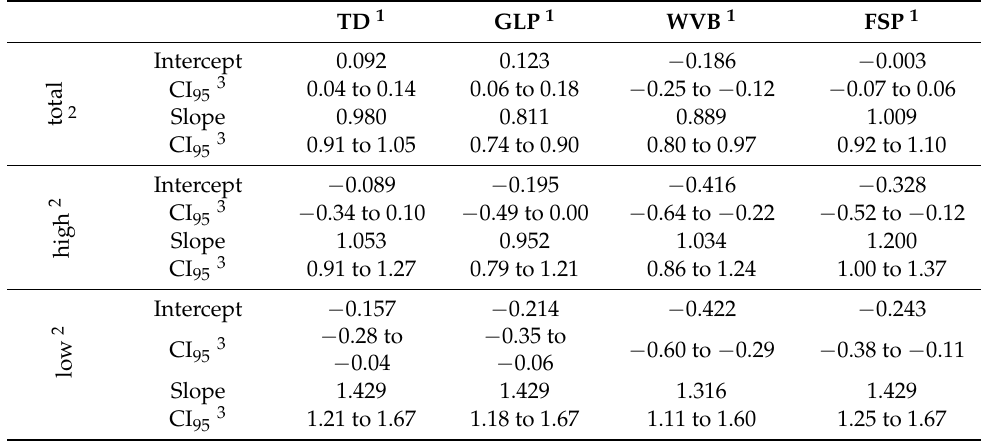
Table 4. Passing–Bablok regression coefficients calculated for the classes total, high and low for BHBA concentrations measured in whole blood with 4 handheld devices in comparison with the BHBA concentration in blood serum (BHBA LAB ) analyzed in the laboratory. TD 1 GLP